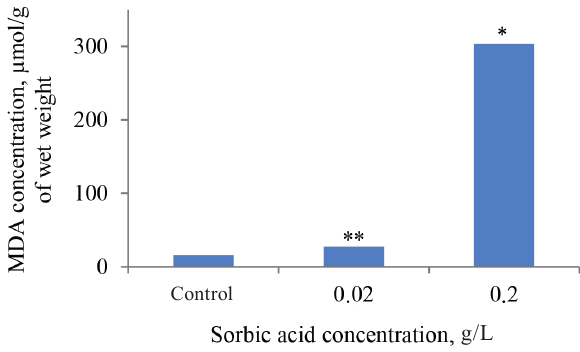
Control Figure 7 Effect of different doses of sorbic acid on MDA level in roots after 2 days of incubation (n = 9). * P < 0.05, ** P < 0.1